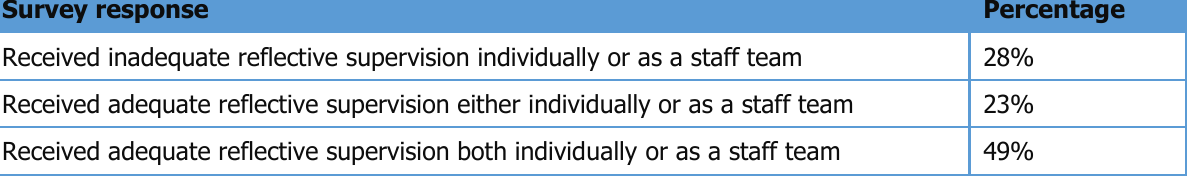
Table 1. Survey Results: Percentages of Inadequate and Adequate Reflective